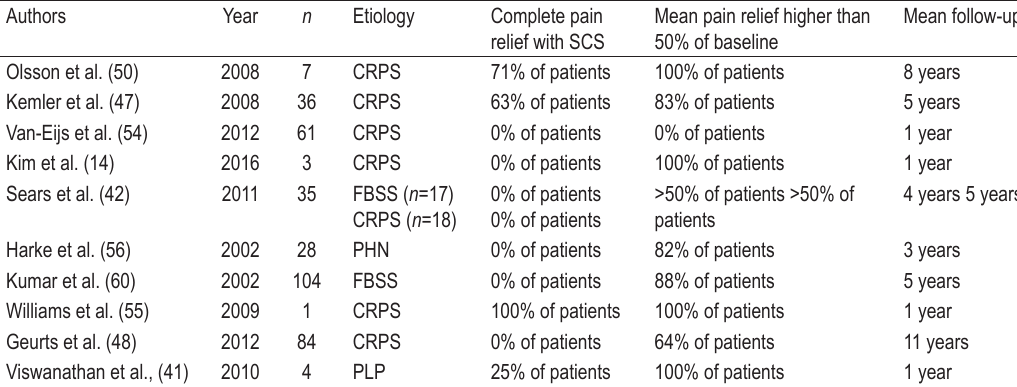
TABLE 2. Pain control rates of